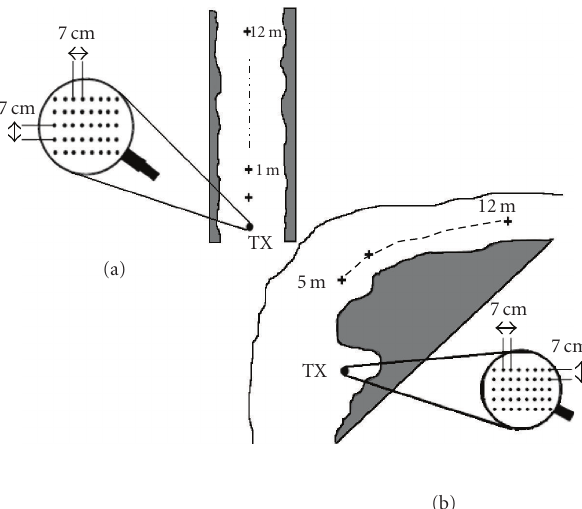
Figure 4: Transmitter/receiver positioning (a) LOS case , (b) NLOS